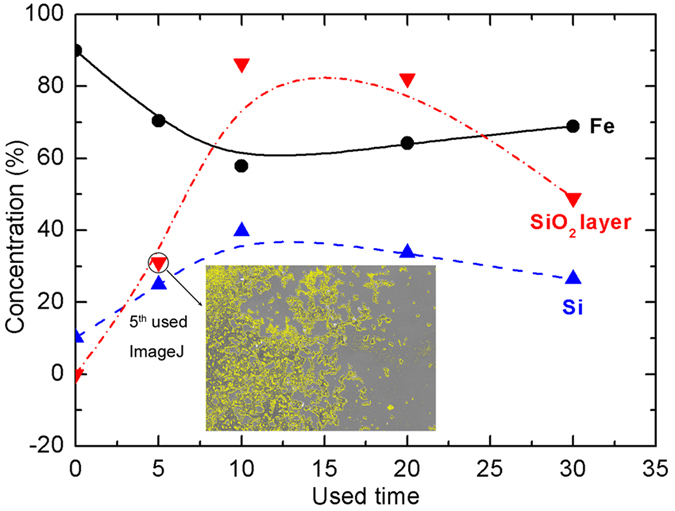
Changes of Fe, Si and SiO2 layer percentages for various used Fe78Si9B13 ribbons (inset, SiO2 layer percentage for 5th use ribbons, surface fitted by imageJ).